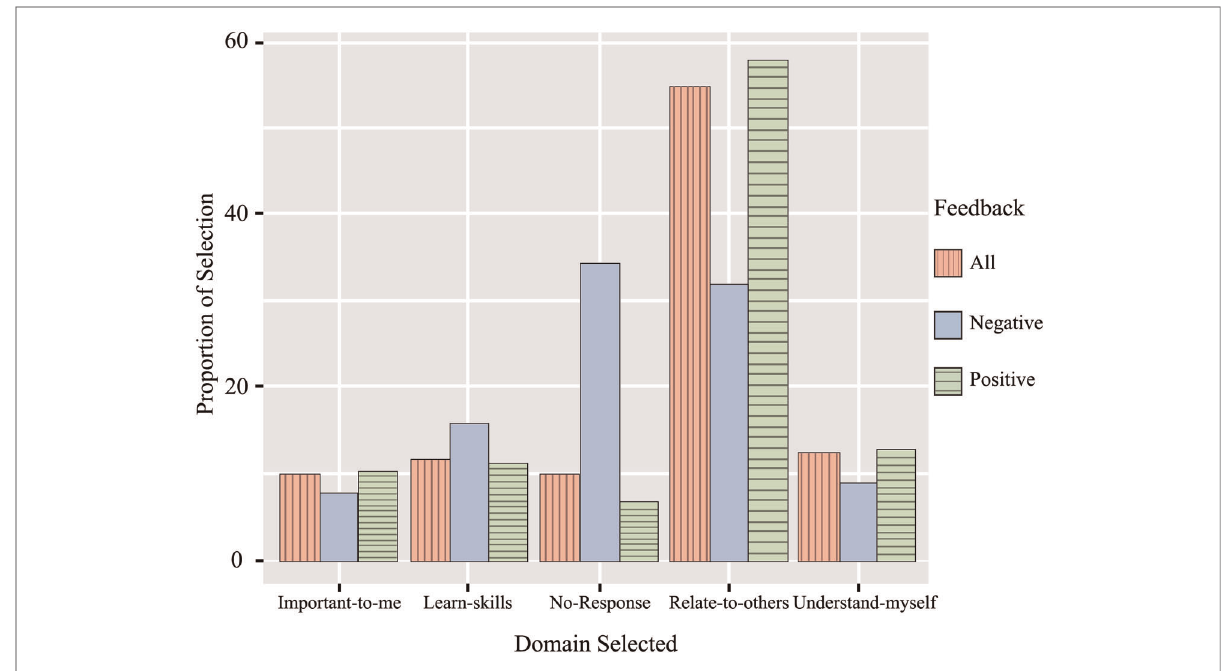
FIGURE 6 Frequency of selection for high-level support domains in process assessment of the measure for each type of feedback.